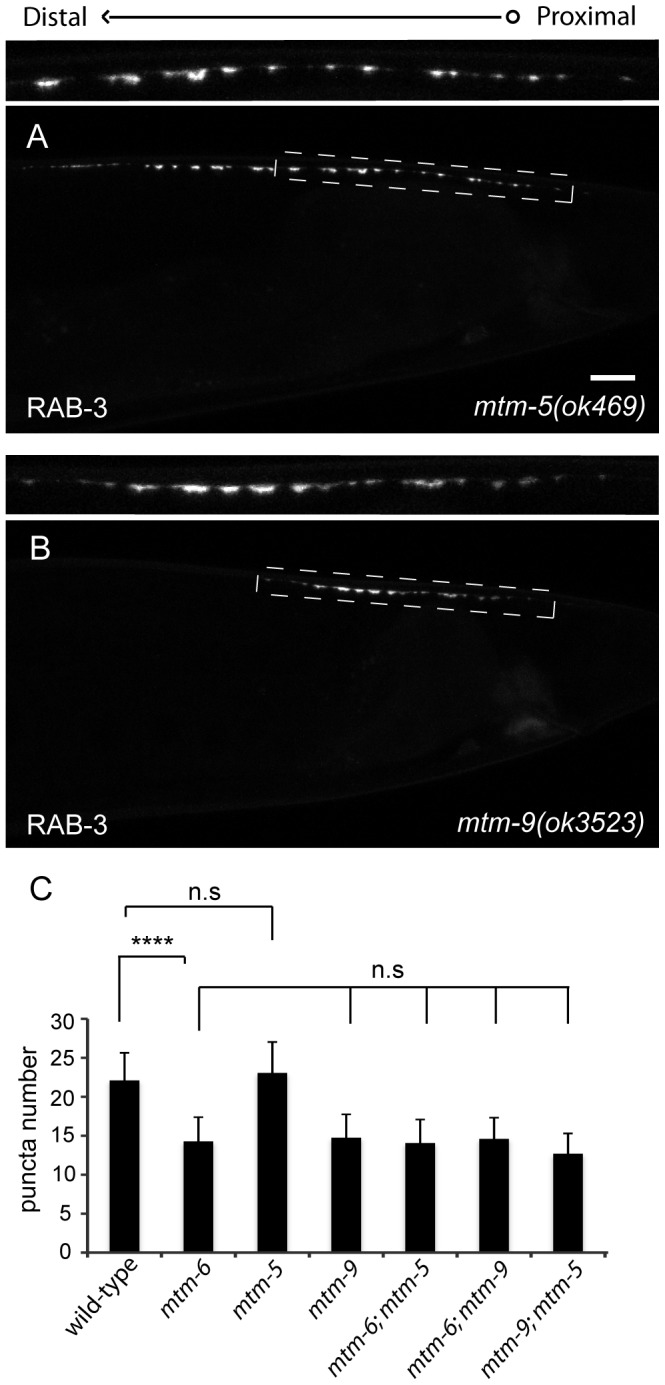
Loss of mtm-9, an inactive myotubularin, shows a reduced number of presynaptic puncta.(A) A mutant for the inactive myotubularin mtm-5 has a similar number of GFP::RAB-3 puncta when compared to wild-type. (B) A mutant for the inactive myotubularin mtm-9 has a reduced number of GFP::RAB-3 puncta, similar to the mtm-6 mutant. (C) Quantification of single and double mutants for the inactive myotubularins (n>60, **** is p<0.0001, n.s. is not significant, and error bars are SD). The dashed boxes mark the regions that are enlarged for the insets above each window. Scale bar is 10 µm.